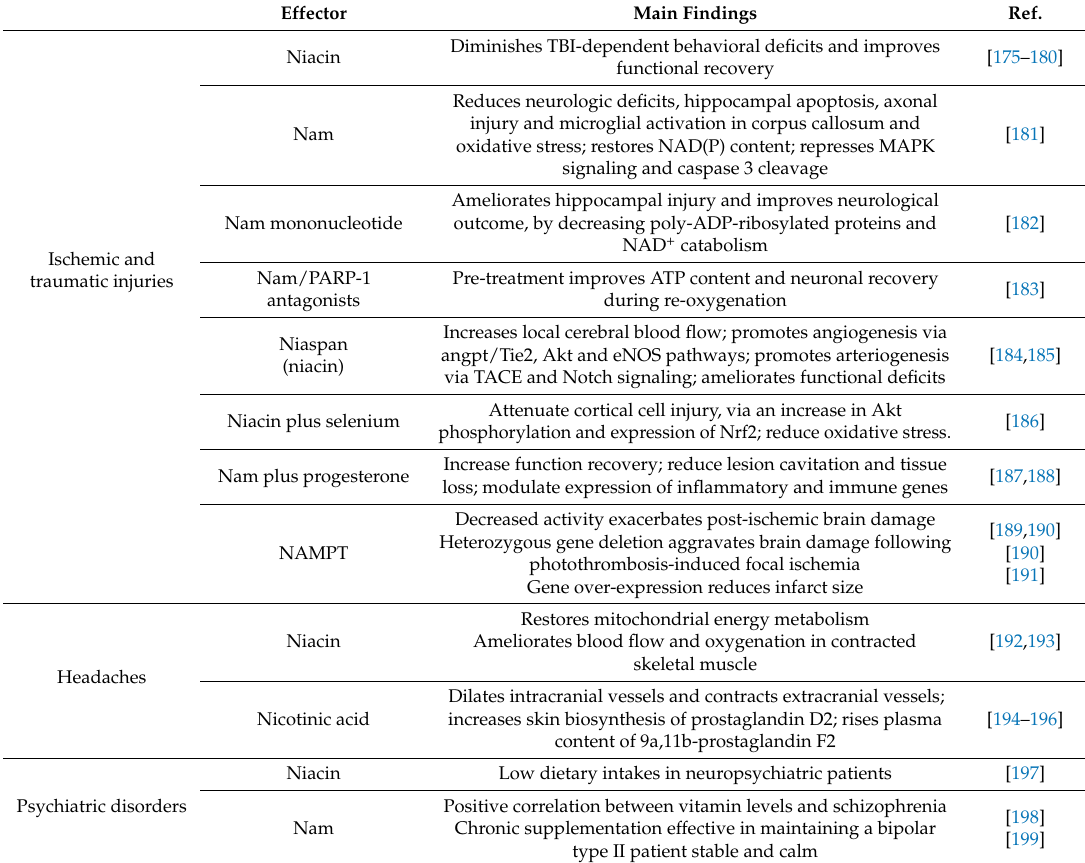
Table 2. Main findings on the role of niacin in other neurological diseases. Effector Main Findings